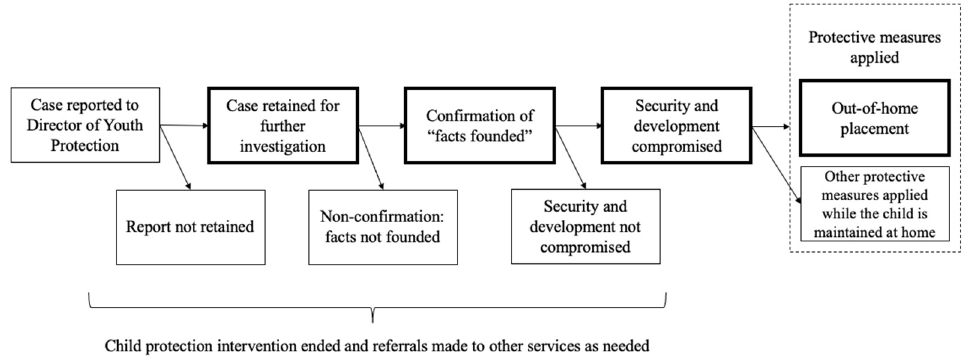
Figure 1. Overview of child protection decision points upon receipt of a report concerning a child in Quebec (bolded boxes indicate stages of focus in the present study).